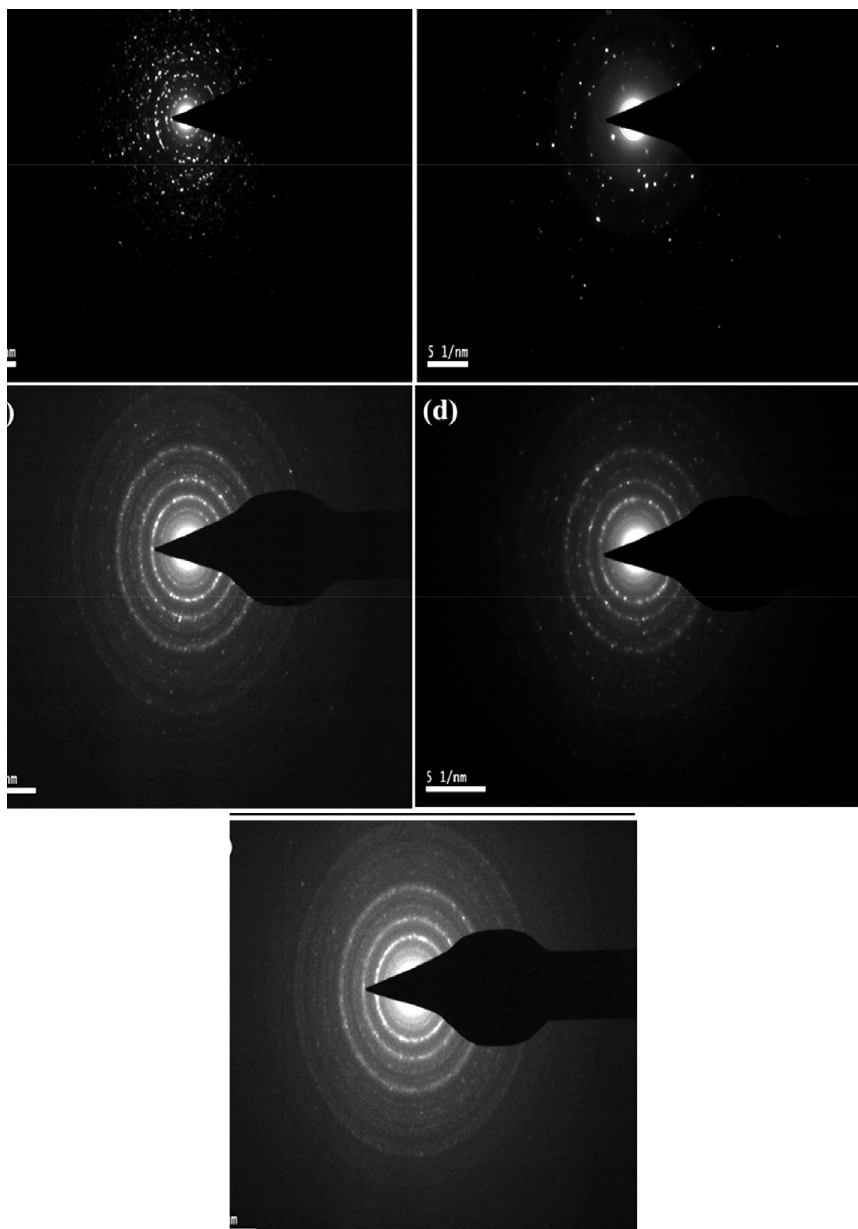
Figure 10. SAED pattern of (a) YbPO 4 :Tb 3+ (SC) (b) YbPO 4 :Tb 3+ (HT) (c) YbPO 4 :Tb 3+ (ST) (d) YbPO 4 :Tb 3+ (Sac) (e) YbPO 4 :Tb 3+